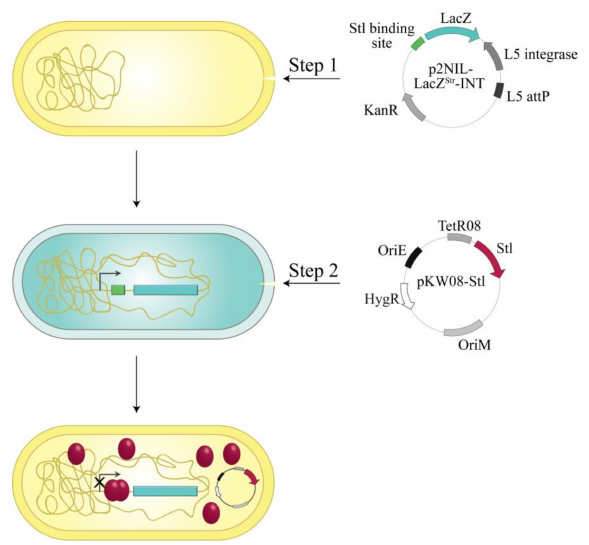
Figure 2. Workflow of the in vivo Stl:DNA binding assay: The p2NIL-LacZ Str -int vector carrying the desired Stl binding site in the promoter region of lacZ gene was electroporated into M. smegmatis cells (Step 1). After electroporation, this vector integrates into the genome. This is followed by Step 2: electroporation of pKW08-Stl vector into the Stl switch system. Stl expression is inducible in a tetracycline-dependent way.